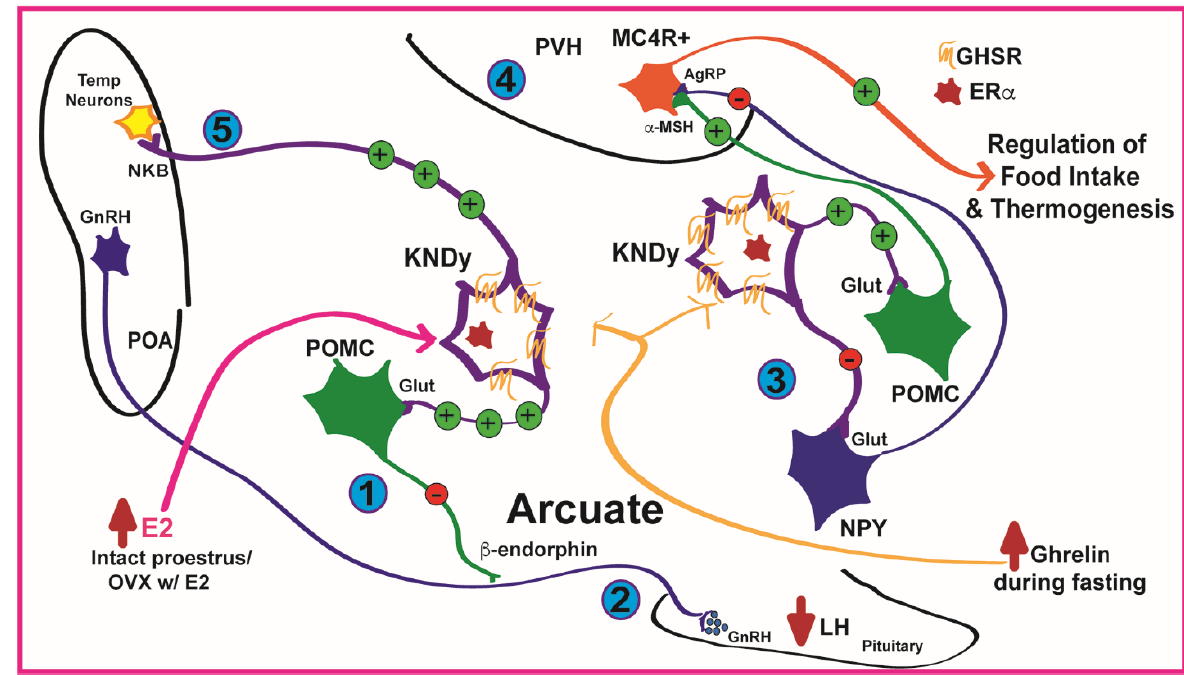
Figure 9. Schematic of hypothesis that E2 increases KNDy sensitivity to ghrelin in females by aug- menting Ghsr expression to suppress the LH production during states of elevated ghrelin (caloric restriction), and to diminish the orexigenic input of ghrelin from NPY neurons by activating POMC neurons, via glutamate, and to control thermogenesis and heat dissipation via activation of sympa- thetic tone from POMC innervation into the PVH and via the release of neurokinin B in the Preoptic Area (POA), respectively. During states of elevated E2 (proestrus or OVX with E2 replacement), Ghsr expression is increased in KNDy neurons augmenting KNDy sensitivity to ghrelin (1). The increase in KNDy sensitivity to ghrelin augments KNDy neuronal output via glutamate onto ARC POMC and NPY/AgRP neurons. Activation of POMC neurons would increase the release of β -en- dorphin on GnRH neurons thereby suppressing LH (2). The ghrelin increase during fasting en- hances KNDy inhibition of NPY/AgRP neurons via glutamate (3) and POMC activation would also increase the release of α -MSH on MC-4 receptor (MC4R)-expressing neurons in the PVH to reduce food intake in opposition to ghrelin’s activation of the feeding drive through NPY neurons (4). Fi- nally, ghrelin-activated KNDy neurons projecting to the POA release NKB to control thermoregu- latory output from the POA and heat dissipation (5).